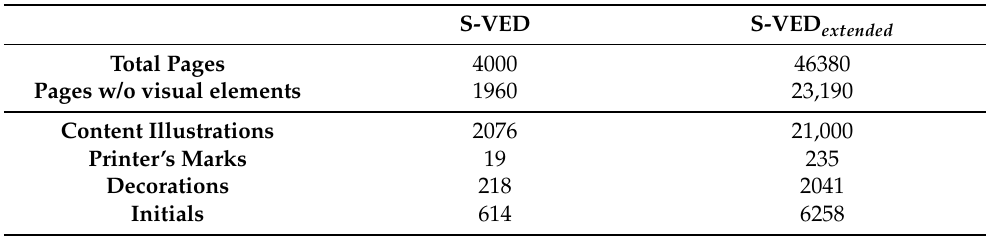
Table 1. The total number of pages, pages without any visual elements, and samples per class in S-VED and S-VED extended